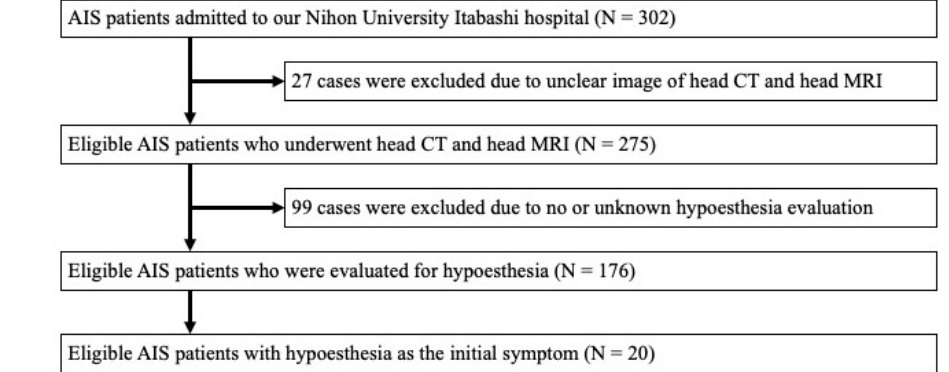
Figure 1. Study fl ow chart. Figure 1. Study flow